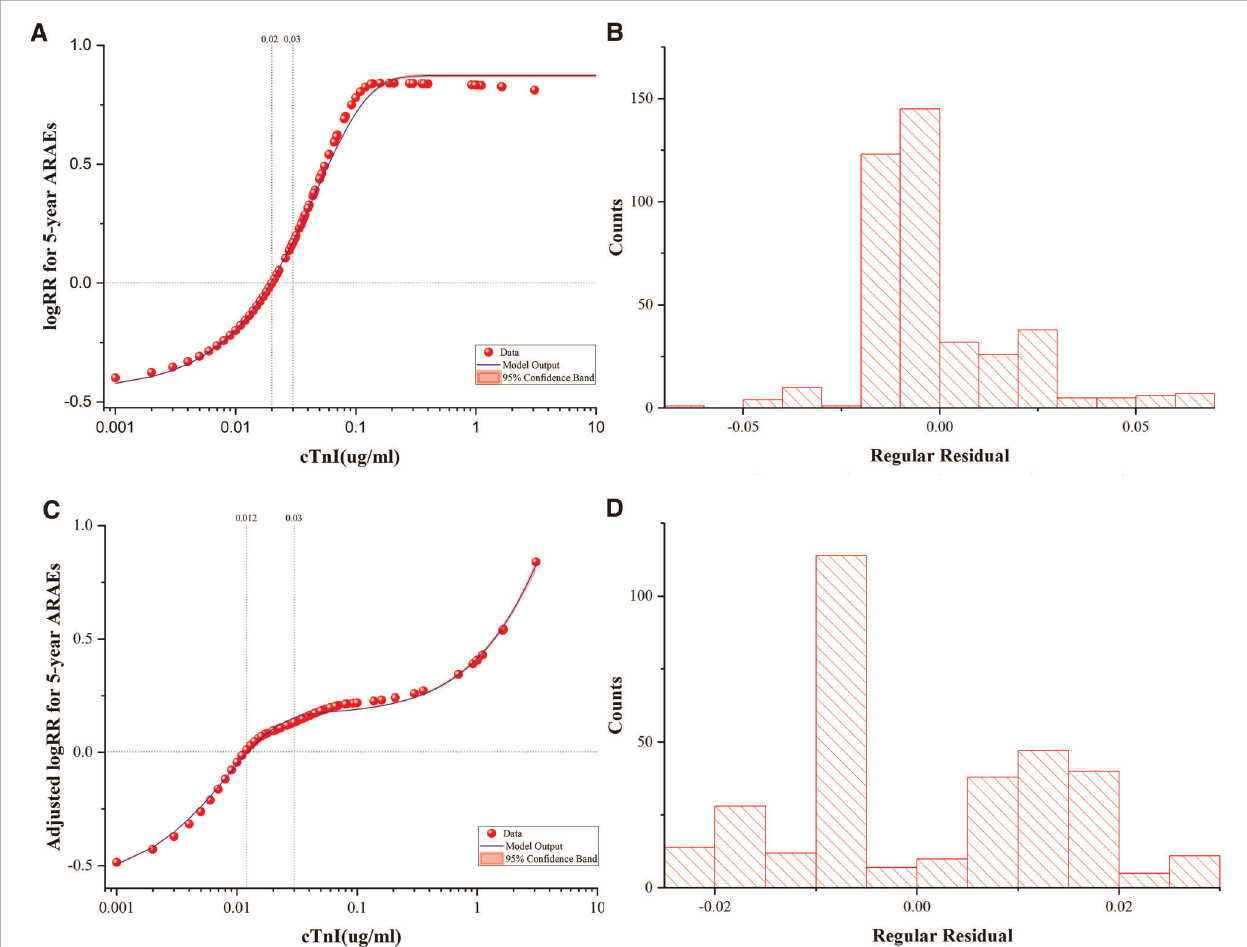
FIGURE 5 | Fitted Curves and Residual Plots. The unadjusted and adjusted logRRs for 5-year ARAEs by different levels of cTnI. ( A ) Unadjusted logRR for 5-year ARAEs by the levels of cTnI. ( B ) Frequency histogram of residual plots in an unadjusted best- fi t plot. ( C ) Adjusted logRR for 5-year ARAEs by the levels of cTnI. Adjusted curves were generated using the Cox model as the average of the model-based curves at observed pro fi les for the following covariates: age, sex, body mass index, chronic kidney disease, D-dimer and neutrophil counts. ( D ) Frequency histogram of residual plots in an adjusted best- fi t plot. logRR, log relative risk; ARAEs, aortic-related adverse events; cTnI, cardiac troponin